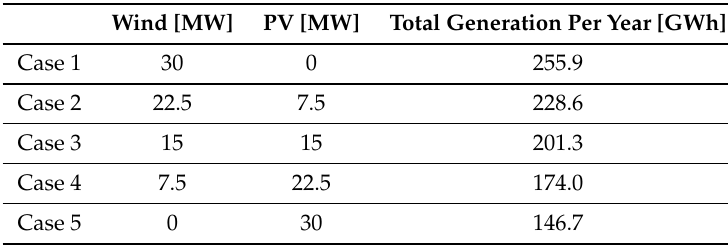
Table 1. Generation mix for forecast error